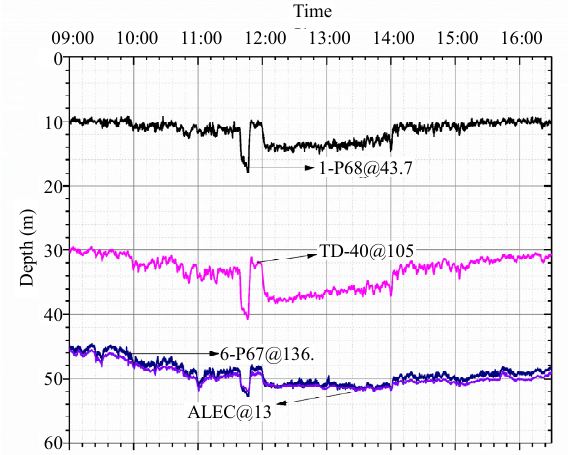
Fig. 10 Data summary of the FBG depth sensor and the electrical depth sensor.